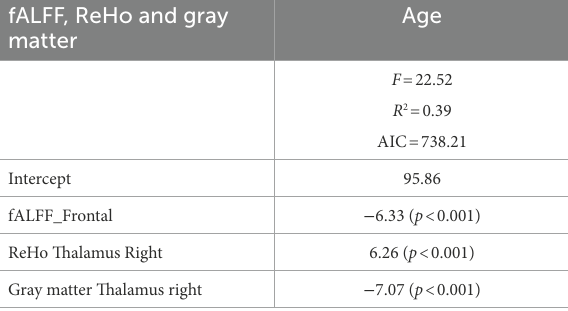
TABLE 5 Parameter estimation ( β ) of the best stepwise linear model for age. fALFF, ReHo and gray